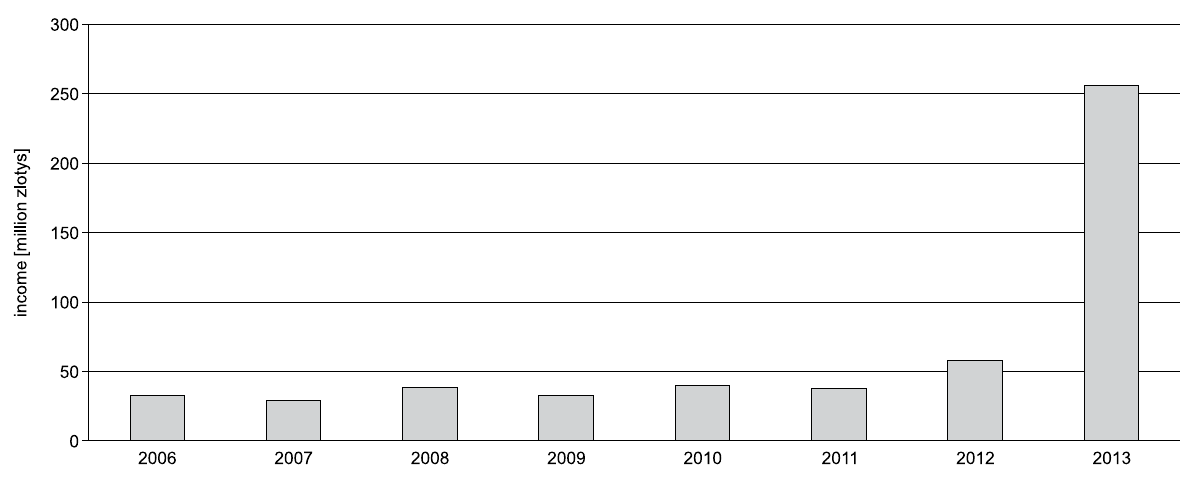
Fig. 3. Dynamics of incomes of inter-municipal bodies organising waste collection and transport in the years 2006–2013. source: own compilation on the basis of the Ministry of Finance